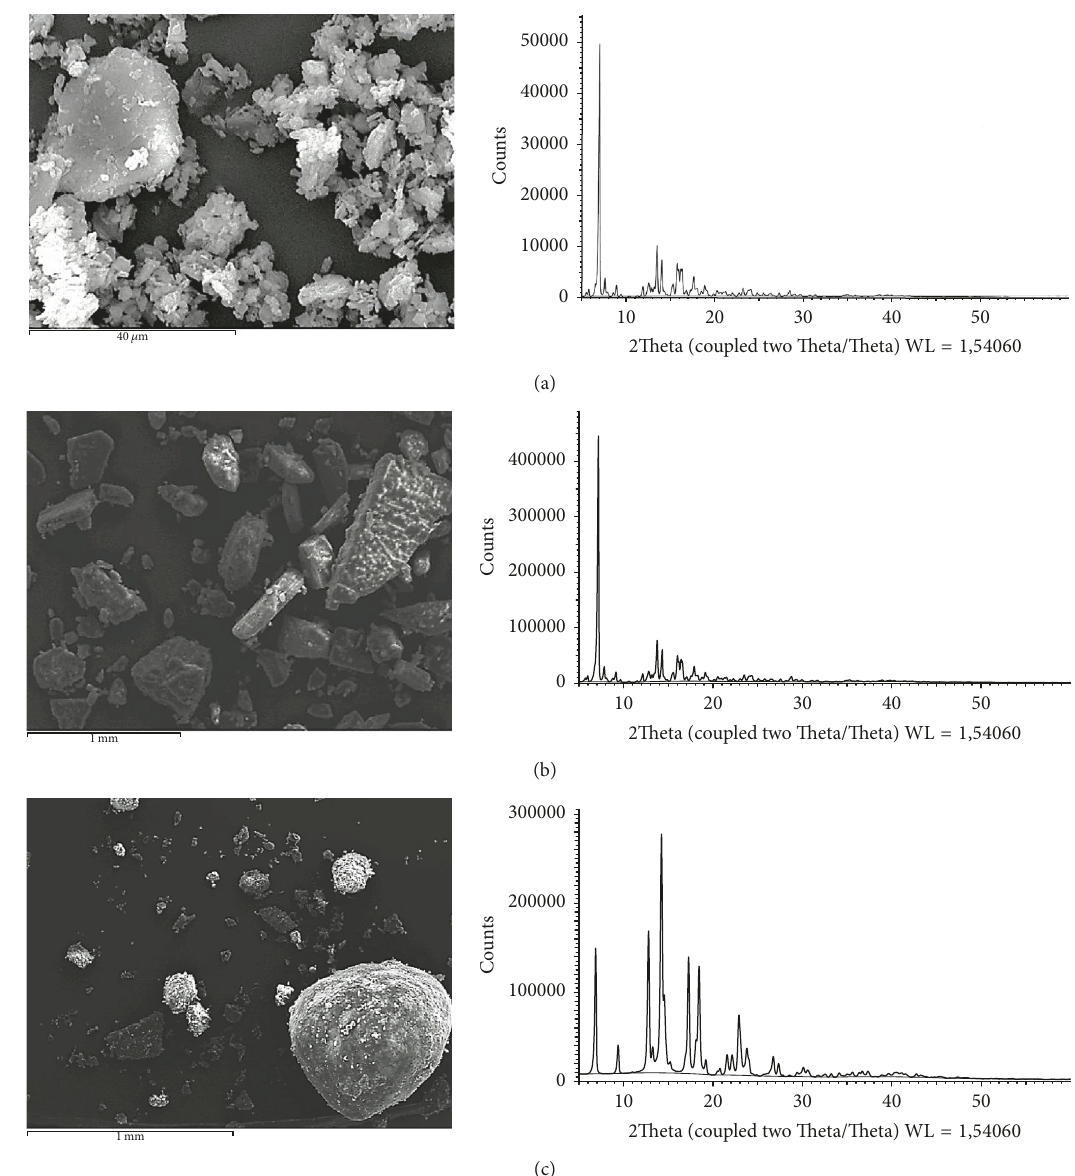
Figure 3: Scanning electron micrographs and X-ray powder diffractograms of FA from Manufacturers A (micronised) and B and C (both nonmicronised). Manufacturers A and B show identical reflexes corresponding to polymorphic Form III. The diffractogram of FA from Manufacturer C shows major differences to A and B and corresponds to polymorphic Form I as described in the